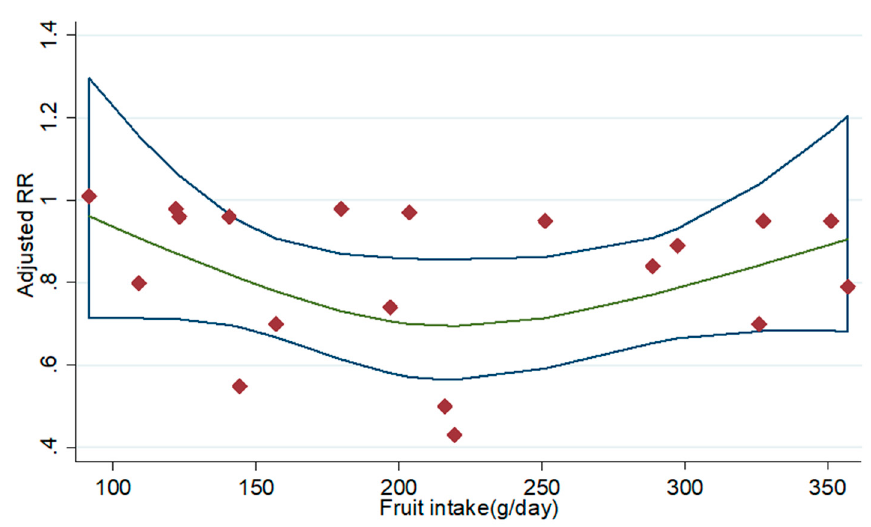
Figure 3. Dose-response analysis for the curvilinear association between intakes of fruit in current smokers and lung cancer risk. Abbreviations: RR—relative risk.